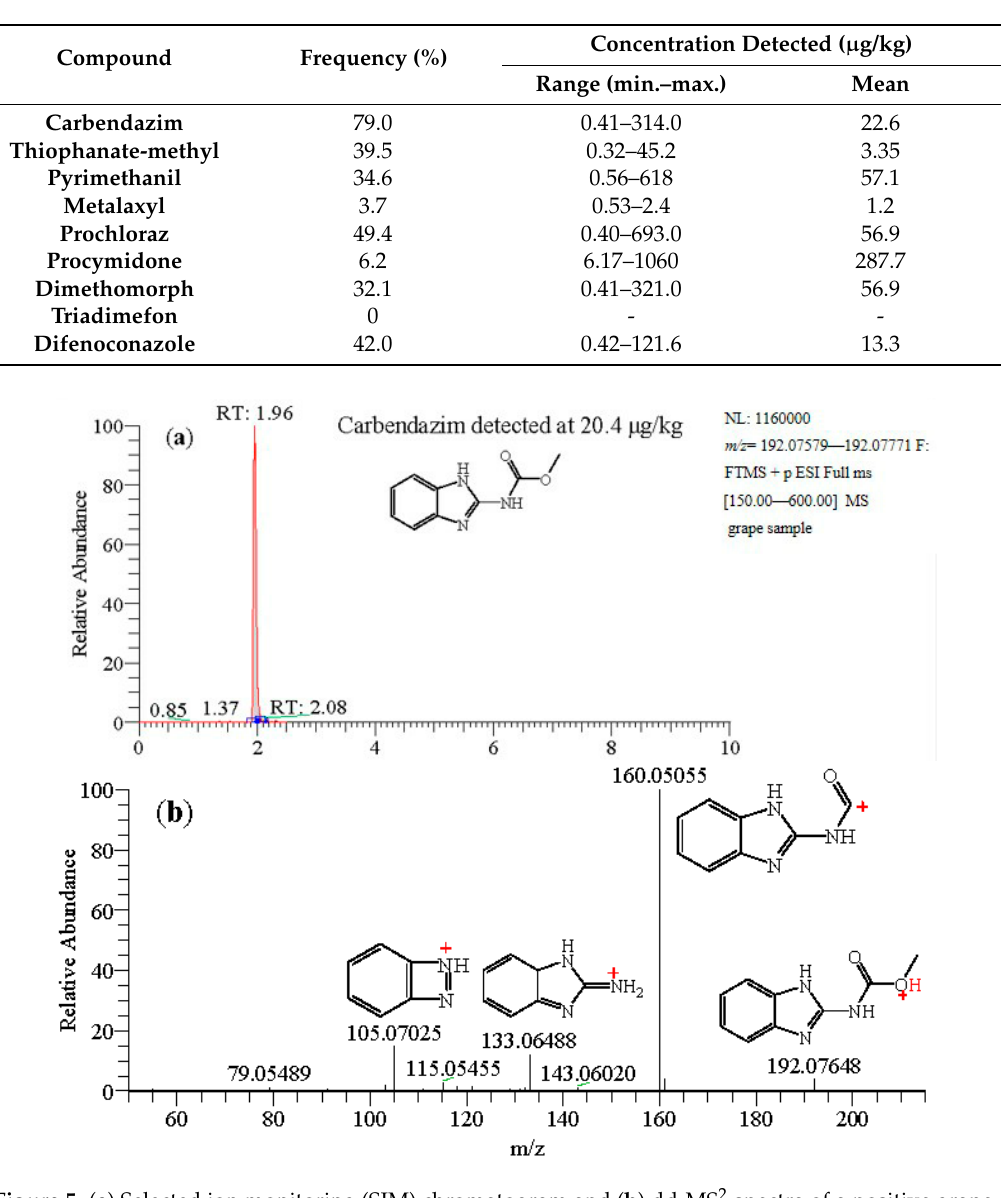
Figure 5. ( a ) Selected ion monitoring (SIM) chromatogram and ( b ) dd-MS 2 spectra of a positive grape sample. RT: retention time.